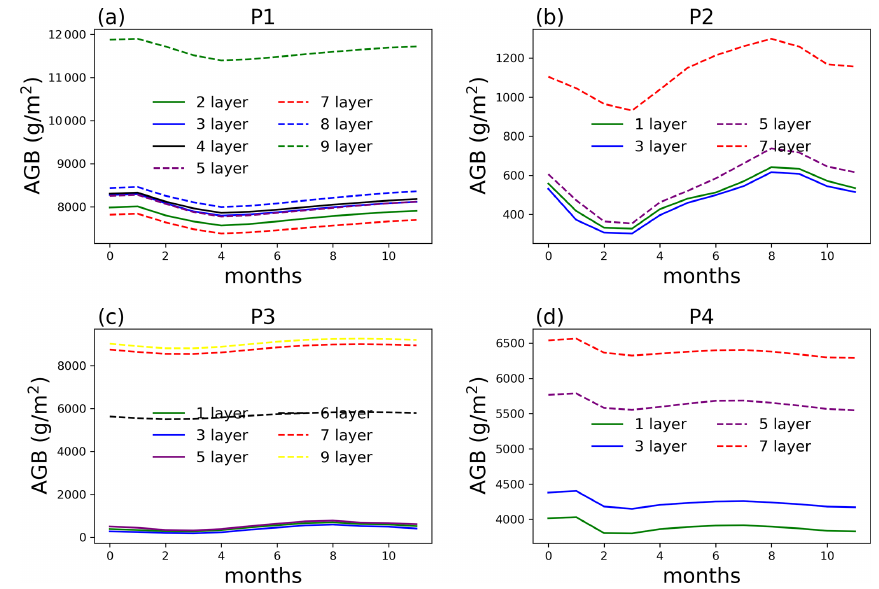
Figure 6. AGB from single-point simulations at selected locations (P1–P4) at year 100 of the simulations.